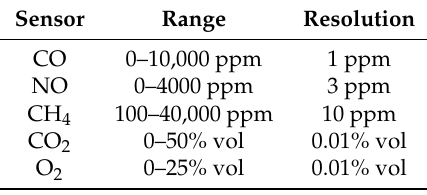
Figure 3. Schematic representation of the test-bench. Table 1. Gas analyzer sensor range and